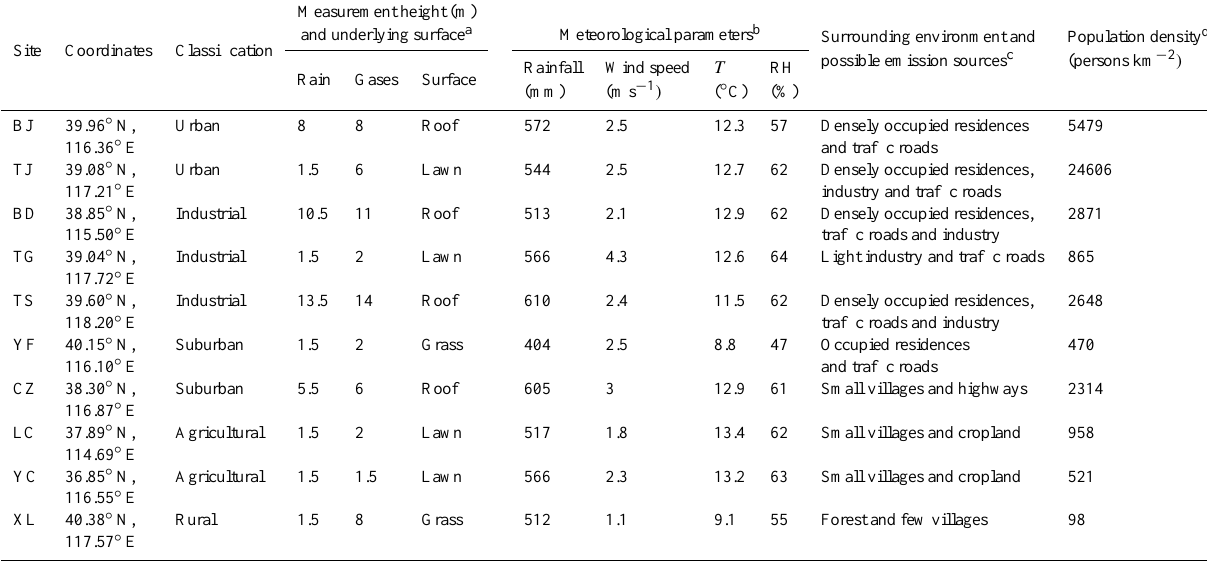
Table 1. Descriptions of the ten sampling sites in Northern